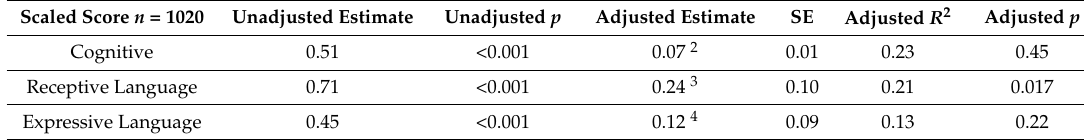
Table 3. Relationships between 10 ng/dL increase for serum 25(OH)D during 2nd trimester with cognitive and language scaled scores 1